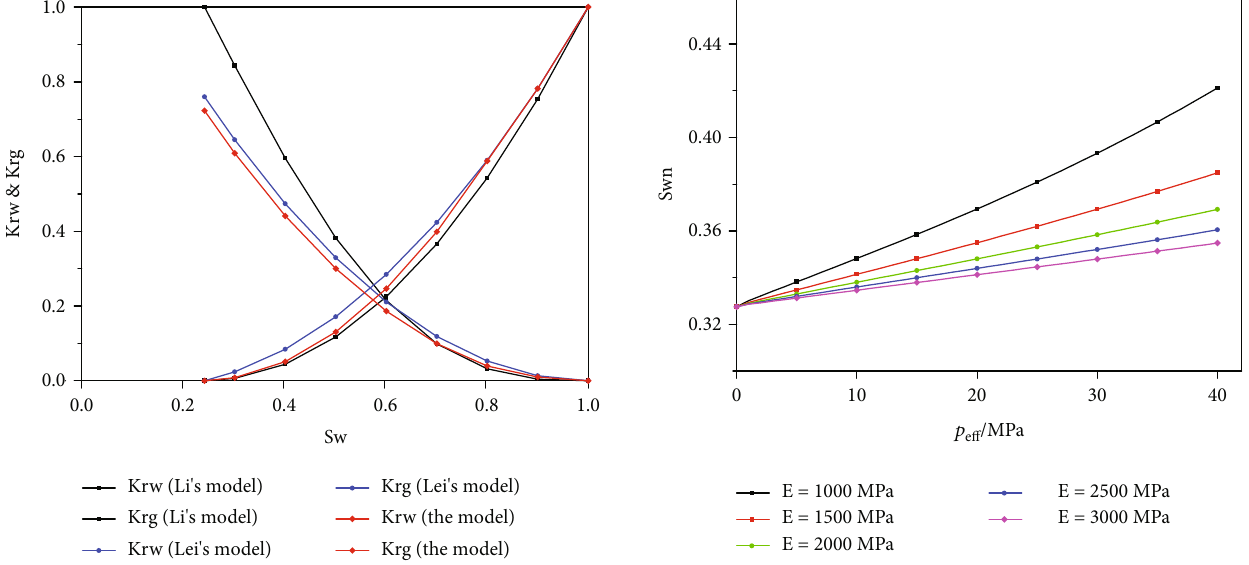
Figure 2: Results comparison of di ff erent relative permeability models with this model.